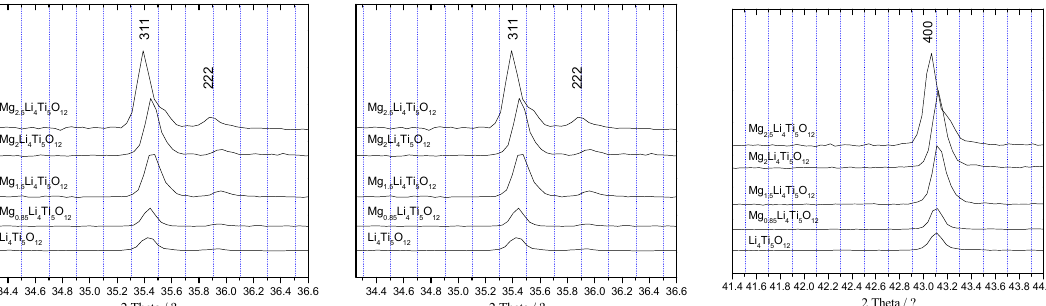
Figure 6. Ex-situ XRD patterns measured during the first discharge in the LTO/Mg cell with 0.5 M Mg(TFSI) 2 + 0.13 M MgCl 2 · 6H 2 O in DME electrolyte. The XRD patterns were recorded at x = 0, 0.85, 1.5, 2, and 2.5 (x in Mg x Li 4 Ti 5 O 12 ) which correspond to 0, 100, 175, 233 and 290 mA h g − 1 capacity, respectively. Note: For the sake of clarity, the zoom of the 111, 311, 222 and 400 peaks is represented. The signal of plastic film is markerd with “ · ” symbol. The “?” symbol denotes some unknown peak not ascribable neither to C (or Ti) substrate nor plastic.